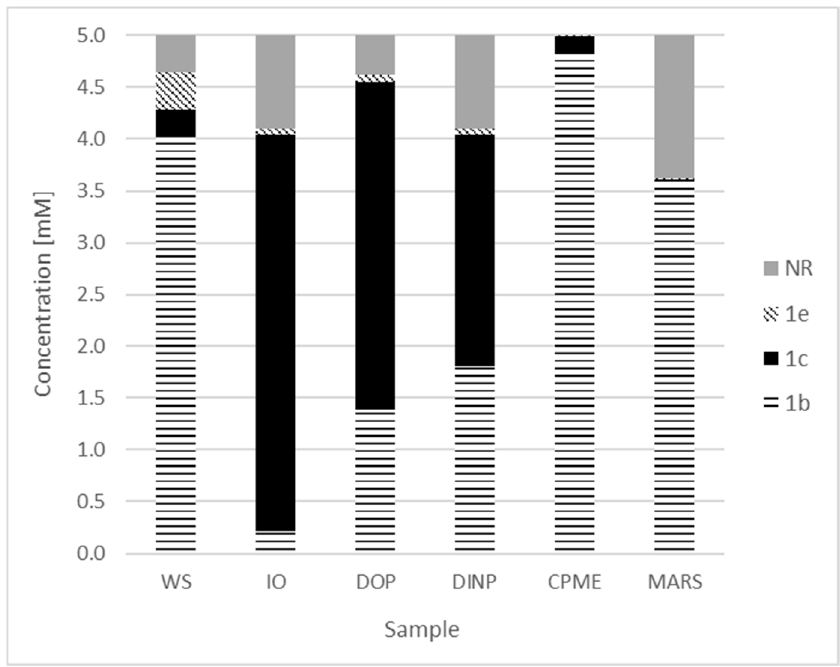
Figure 1. Different co-solvents for in situ product removal in resting cell biotransformations. A total of 5 mM of 1a was dissolved in KOH, WS: without co-solvent, IO: Isooctane; DOP: Dioctylphthalate; DINP: Diisononylphthalate: CPME: Cyclopentyl methyl ether, 50% v/v solvent, 90% v/v CPME for MARS. Standard reaction conditions were 100 mM HEPES, 10 mM MgSO 4 , 50 mM glucose, 40 mg wet cell weight, and total volume of 200 µ L in glass vials; 30 min reaction time. Striped 1b , black: 1c , diagonal squared: 1e (cinnamyl alcohol), grey: not